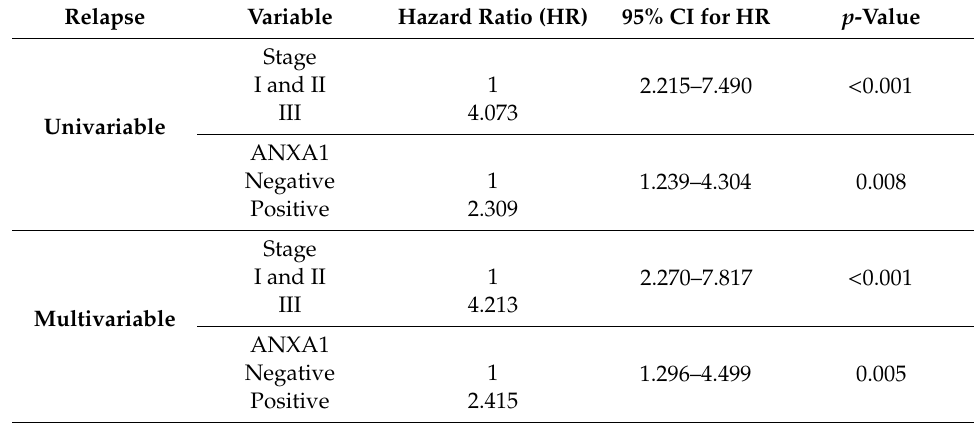
Table 4. Cox regression models assessing the potential of clinical variables and ANXA1 immunoexpression in the prediction of